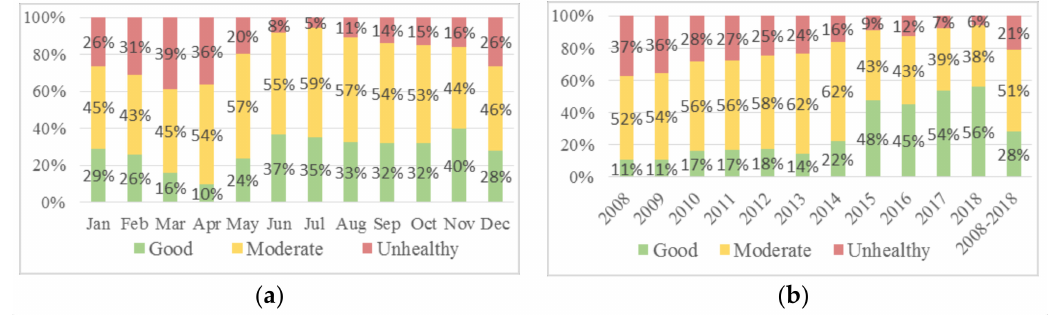
Figure 5. Composition of AQI classes in Zhongli: ( a ) Month-based; ( b ) Year-based and